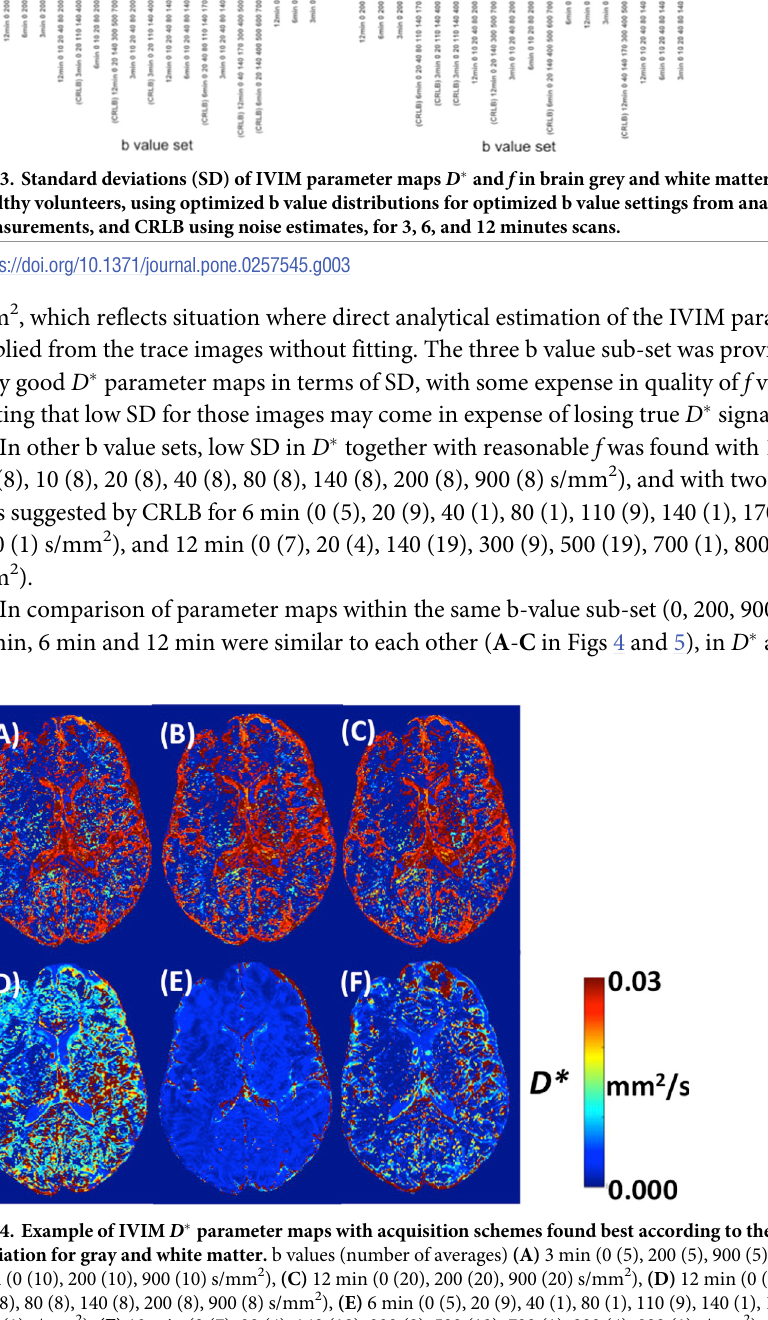
600 (1) s/mm 2 ), (F) 12 min (0 (7), 20 (4), 140 (19), 300 (9), 500 (19), 700 (1), 800 (4), 900 (1) s/mm 2